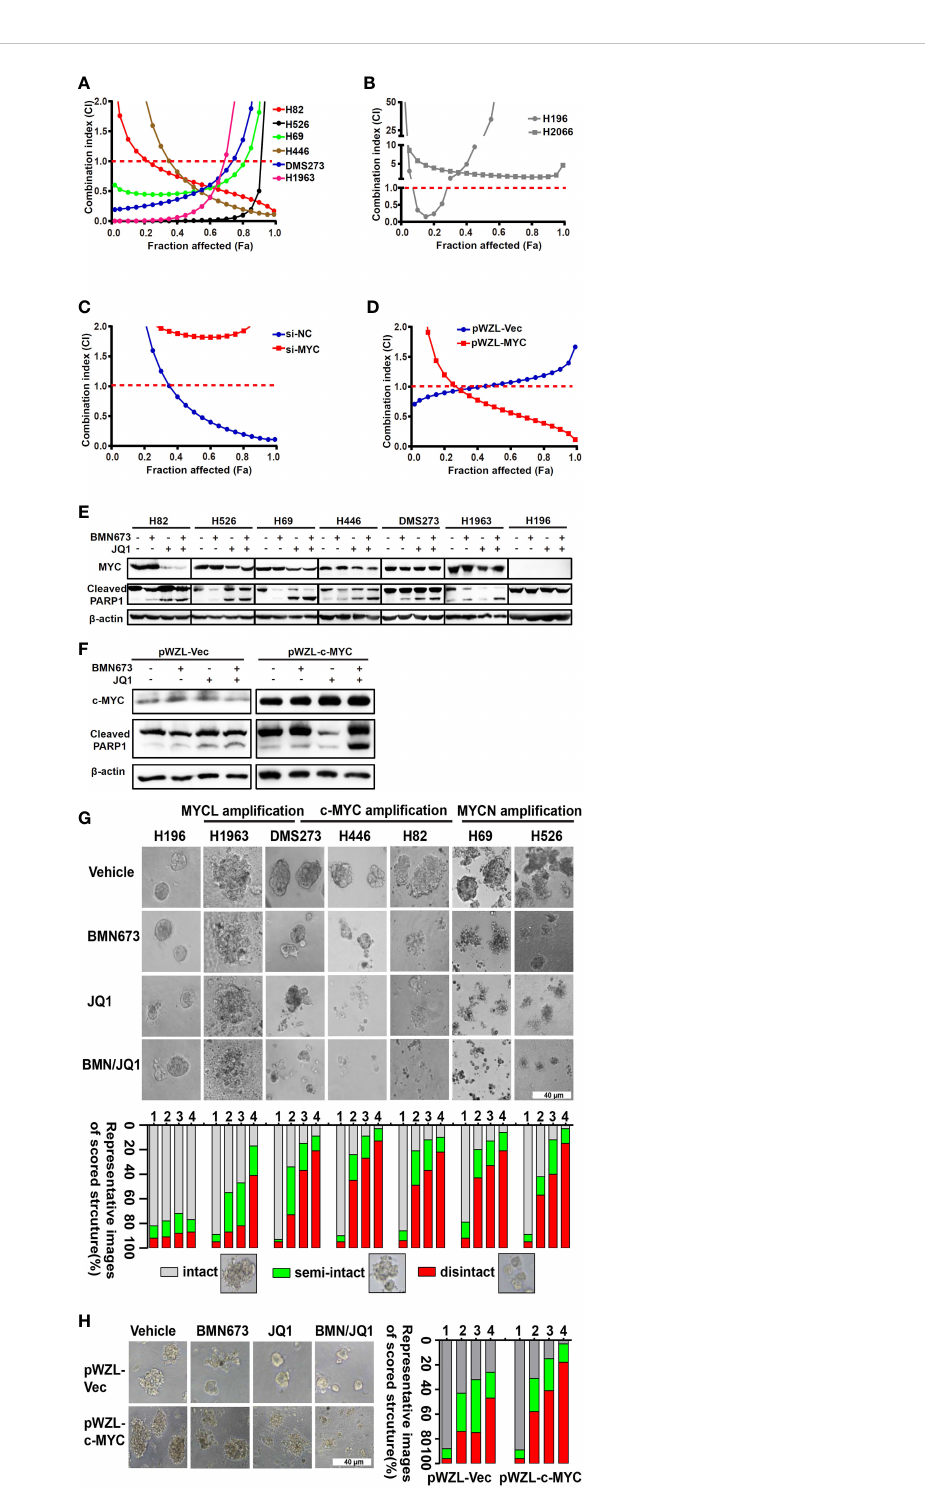
FIGURE 3 The combination effects of JQ1 and BMN673 in SCLC cells. (A – D) CellTiter-Glo Luminescent assays demonstrating the effects of JQ1 and BMN673 as single agents or in combination in MYC paralog-dependent (A) , independent (B) SCLC cells, DMS53 cells with c-MYC knockdown (C) , and SHP77 cells with c-MYC overexpression (D) . A mathematical model was applied to calculate the combination index using the CalcuSyn software program. (E) Western blot analysis of cleaved PARP and MYC paralogs in SCLC cells treated with BMN673 or JQ1 alone or in combination for 24 h. c-MYC for H82, H446 and DMS273, MYCN for H526 and H69, MYCL for H1963. (F) , Western blot analysis of cleaved PARP and c-MYC in SHP77 cells with c-MYC overexpression followed by BMN673 and JQ1 treatment alone or in combination for 24 h. GAPDH was used as a loading control. (G) Tumor sphere structures in 3D matrigel were captured under a phase-contrast microscope upon treatment of JQ1 and BMN673 as single agents or in combination for 10 to 15 days. Representative images of tumor spheres were shown in the top panel. Quanti fi cation of scored tumor sphere structures (disintegrated, semi-disintegrated, and intact) was shown in the bottom panel. Scale bar, 40 m m. (H) 3D matrigel assays showing the effect of JQ1 and BMN673 in SHP77 cells with or without c-MYC overexpression. 1, Vehicle; 2, BMN673; 3, JQ1; 4,